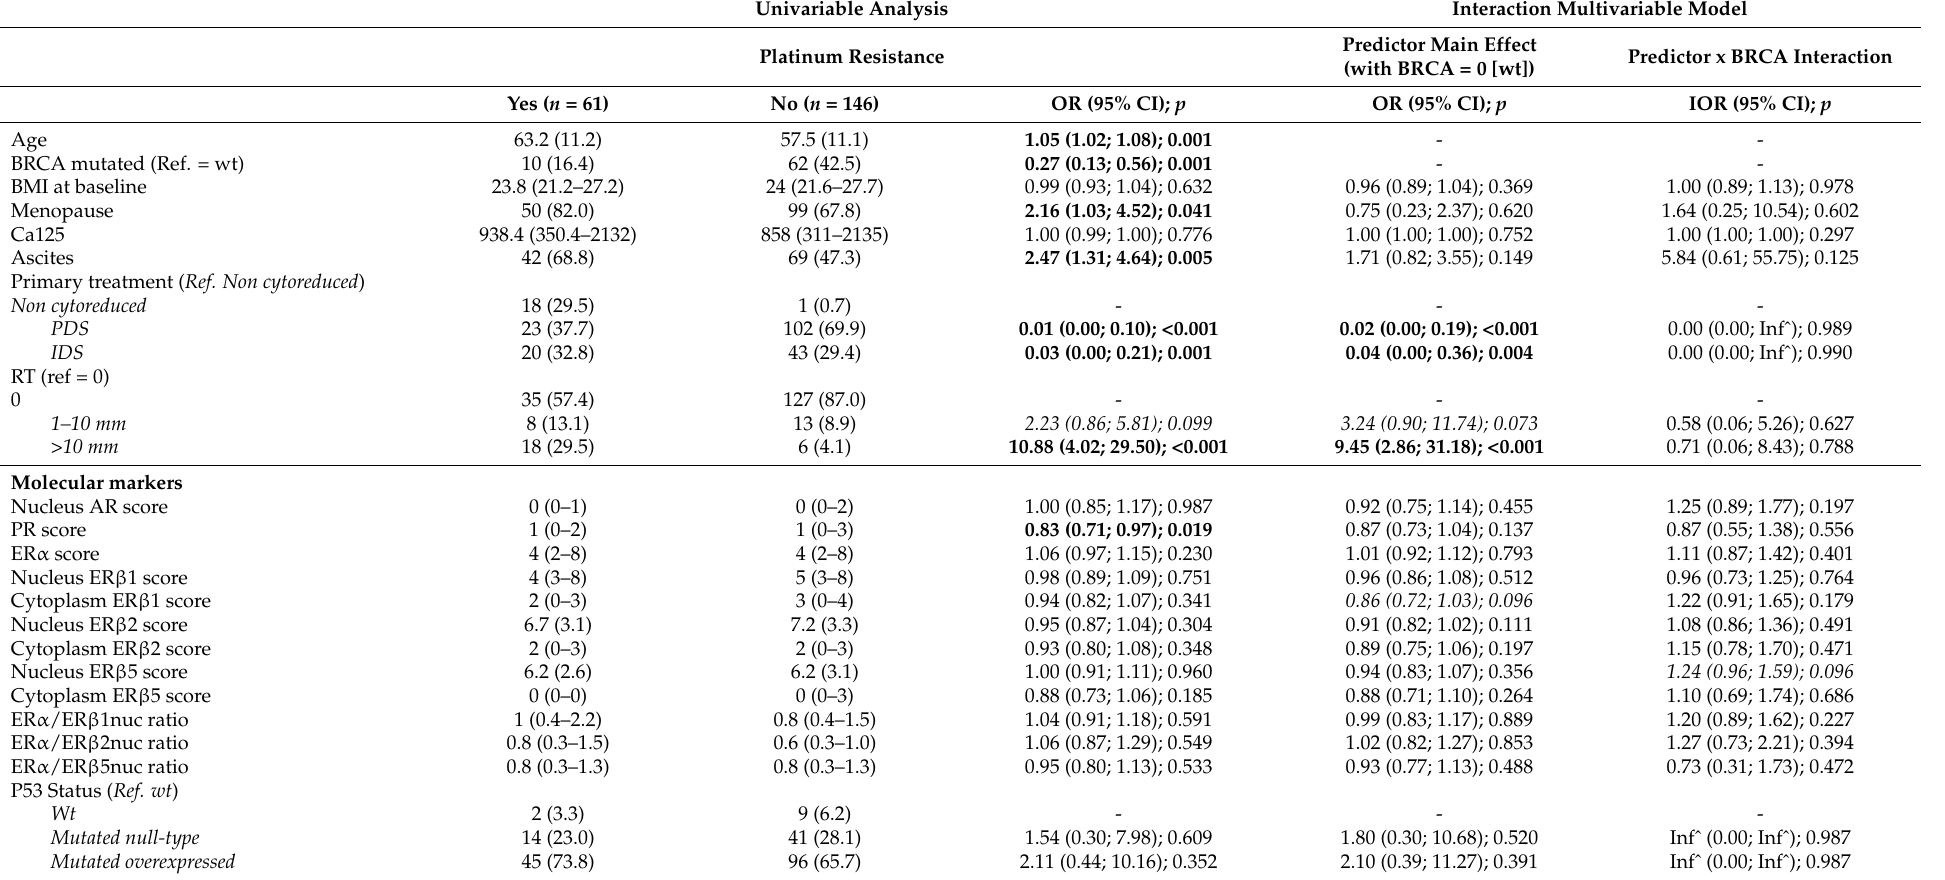
Table 4. Logistic Regression on BRCA-wt vs. BRCA mutated ( n = 207) *.